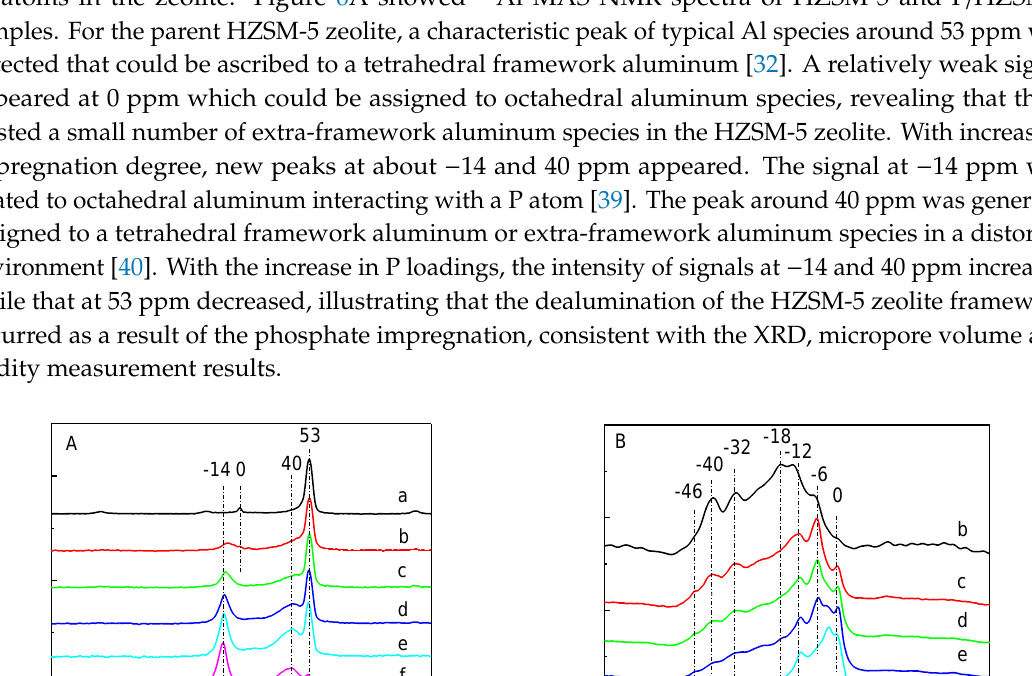
Figure 5. FT-IR spectra of pyridine adsorption on parent and P-modified HZSM-5 zeolites: ( a ) HZSM- 5, ( b ) 0.5% P/HZSM-5, ( c ) 1% P/HZSM-5, ( d ) 2% P/HZSM-5, ( e ) 3% P/HZSM-5 and ( f ) 5% P/HZSM-5.